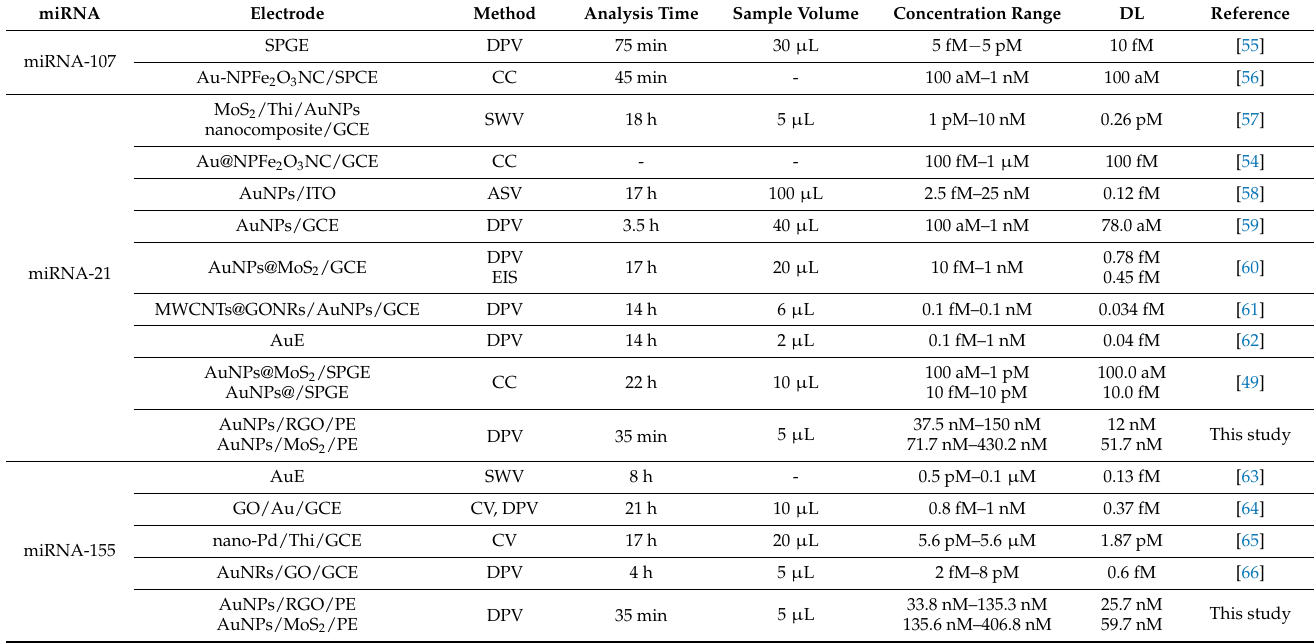
Table 1. Comparison of different electrochemical biosensors for the detection of miRNA-155 and miRNA-21.